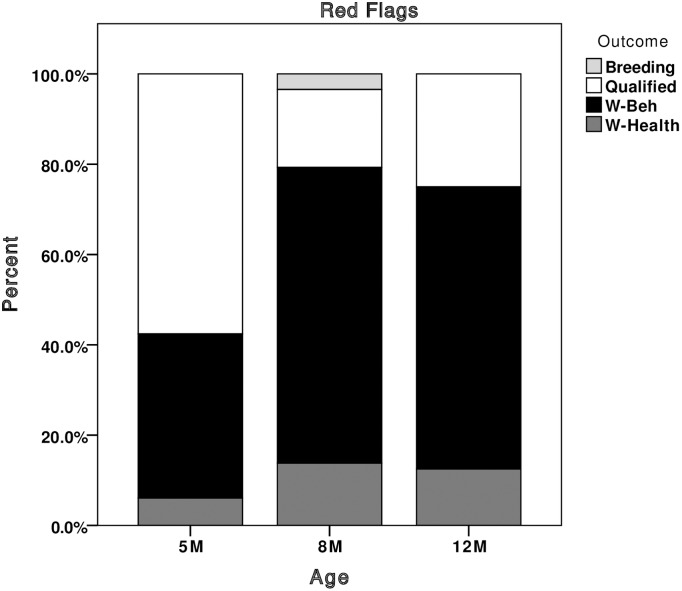
Stacked bar chart showing the percentage of red flags given that would have been out at each assessment, broken down by the dog’s final training outcome.Breeding, dogs selected as breeding stock; Qualified, dogs that qualified as working guide dogs; W-Beh, dogs withdrawn for behavioural reasons; W-Health, dogs withdrawn for health reasons.